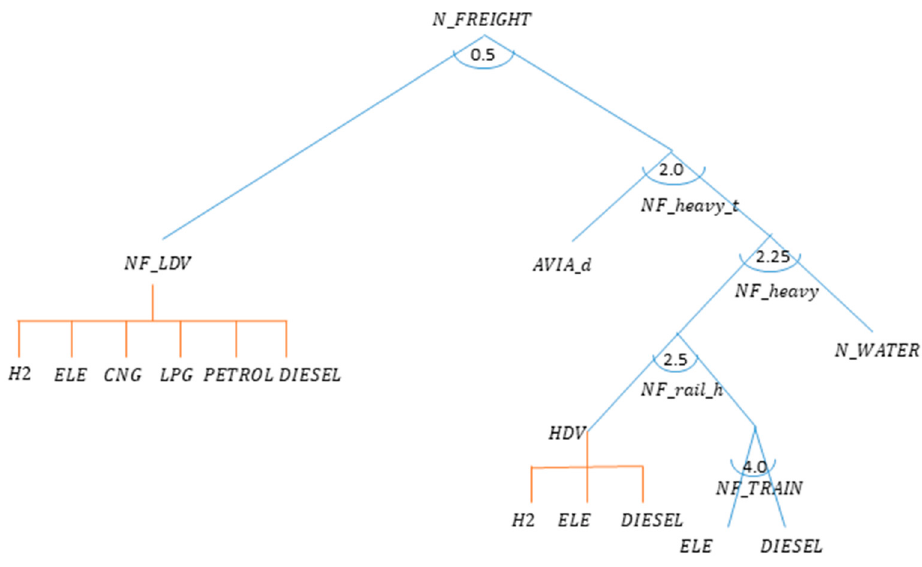
Figure 3. Freight transport decision tree. Source: own elaboration see [28].